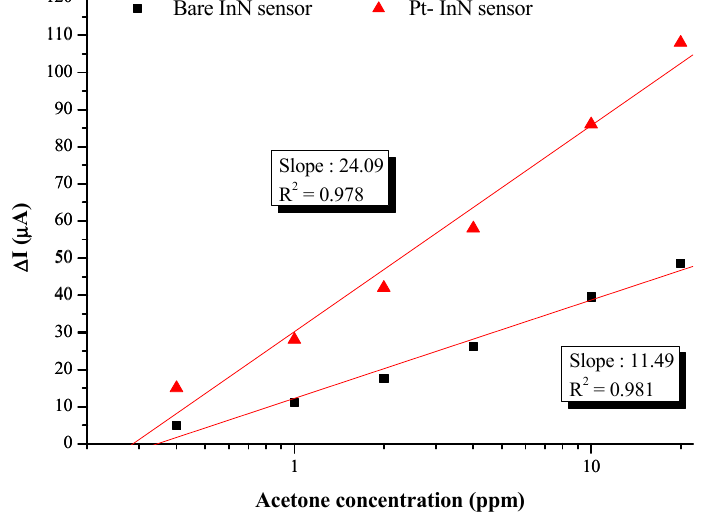
Figure 5. Comparison of current variation of Pt-coated InN and Bare